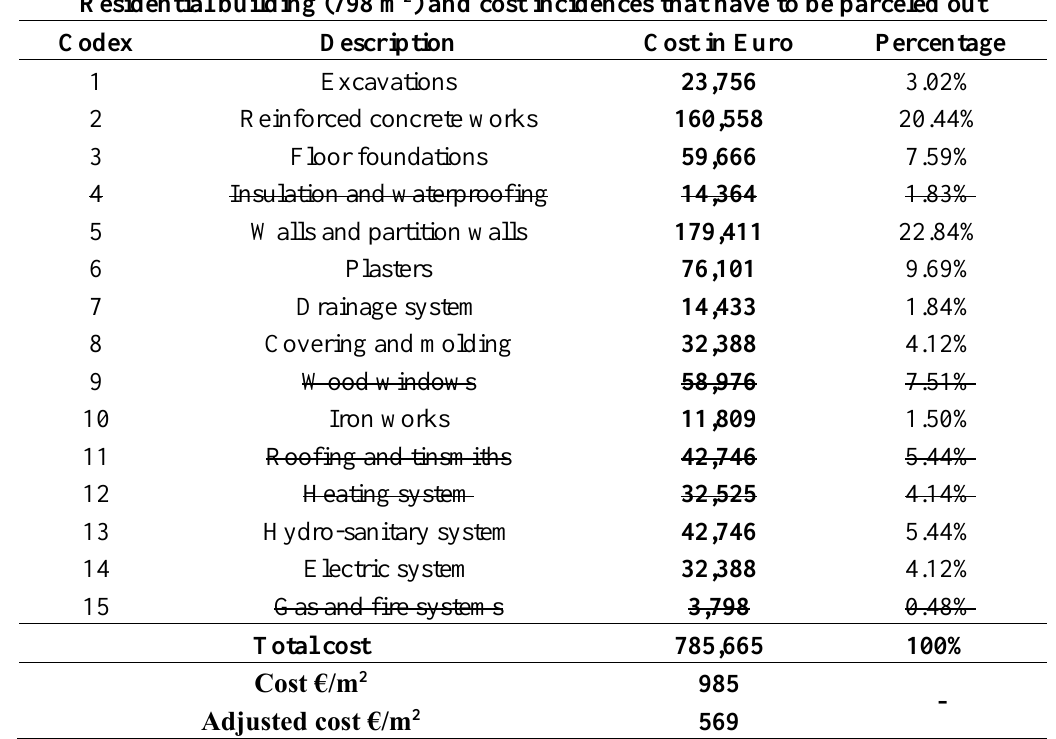
Table 2. Example of the determination of the building fixed costs. Step 1: Original costs of a